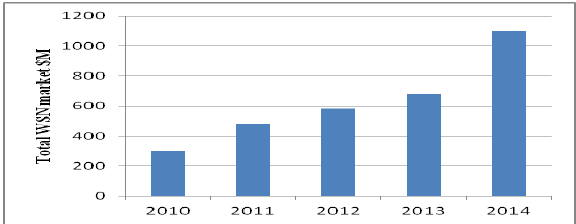
Figure 3. WSN market 2010-2014 ($